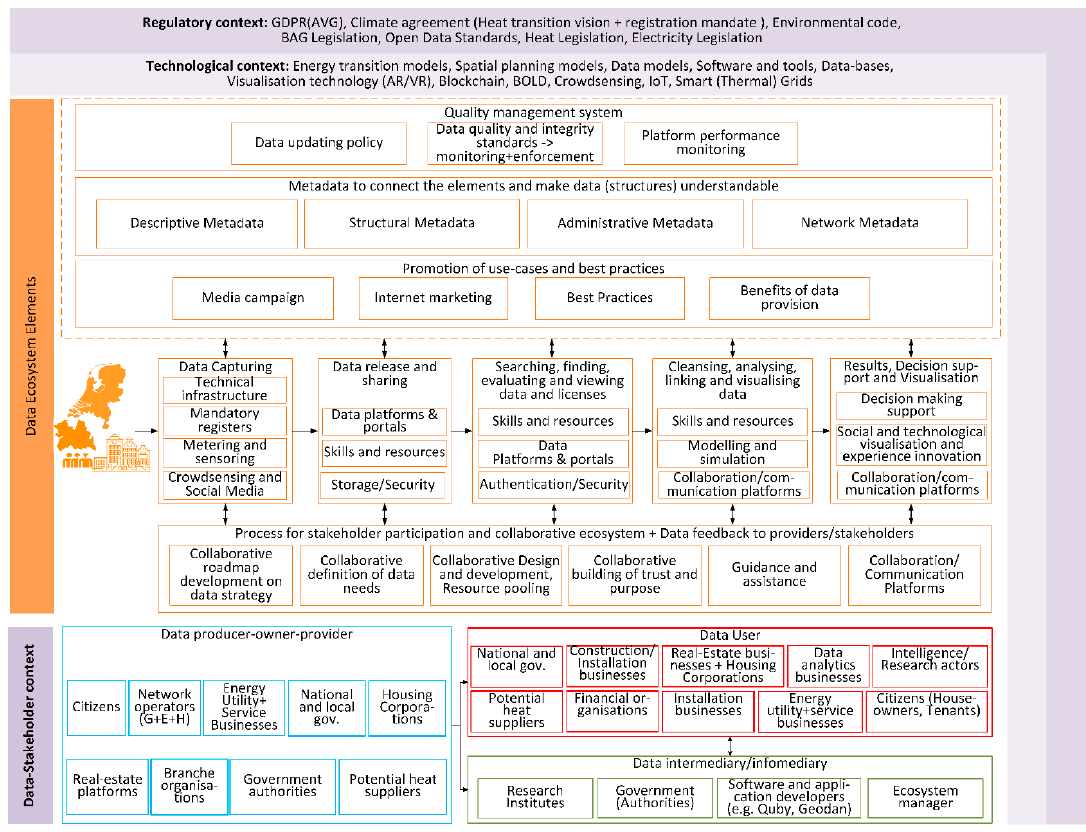
Figure 2. The data ecosystem 2.0 design to support the heat transition in the Netherlands.